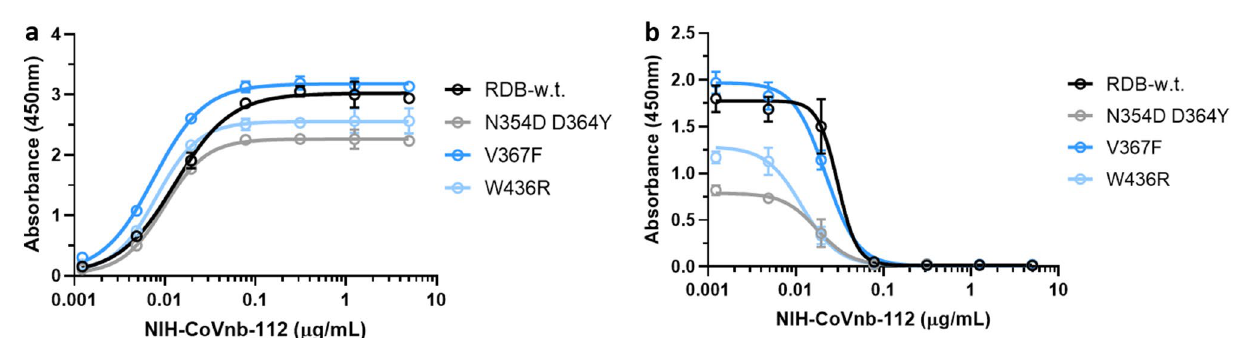
Figure 4. Competitive inhibition of ACE2 and RBD binding using anti-SARS-CoV-2 RBD nanobodies. (a) RBD coated ELISA plates were blocked with non-specific protein and incubated with serial dilutions of each candidate anti-SARS-CoV-2 RBD nanobody. Biotinylated-ACE2 was added to each well and allowed to bind to unoccupied RBD. The ELISA was then developed using a standard streptavidin-HRP and tetramethylbenzidine reaction. Unoccupied RBD allows for a positive reaction signal which is suppressed in the presence of bound competitive nanobody. NIH-CoVnb-112 produces the greatest inhibition of ACE2 binding with an EC 50 of 0.02 µg/mL (1.11 nM). ( b ) Comparable findings using the commercially available Genscript SARS-CoV-2 neutralization surrogate assay.